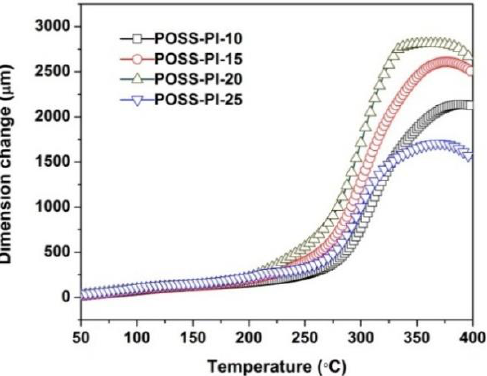
Figure 9. TMA curves of POSS-PI composite films under nitrogen